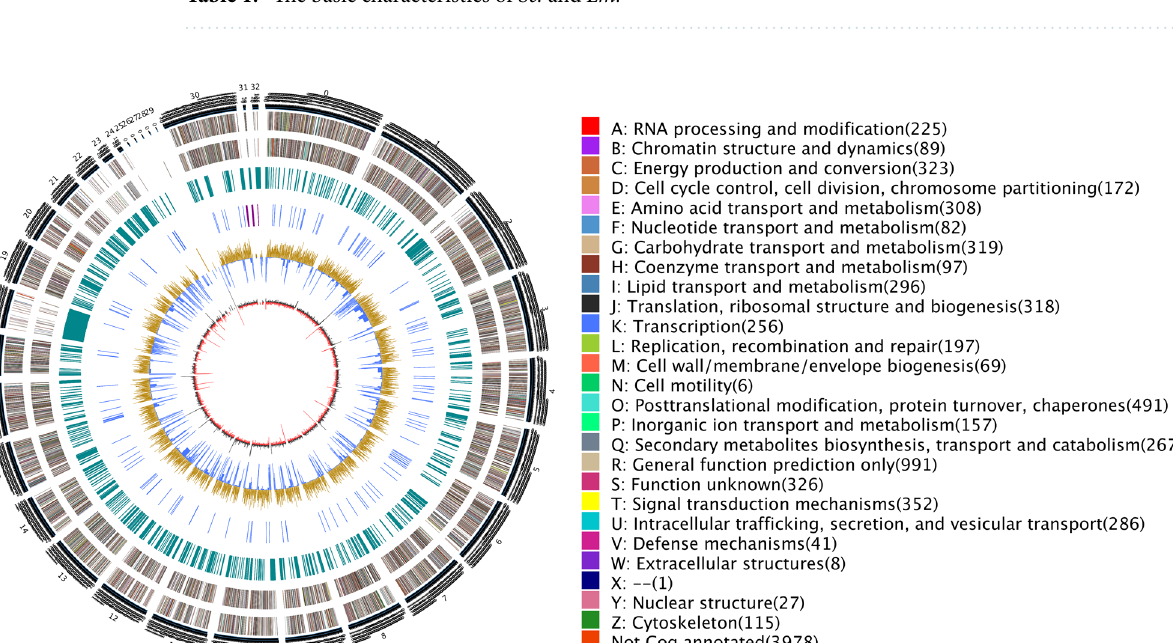
Table 1. The basic characteristics of Sc. and Lm.